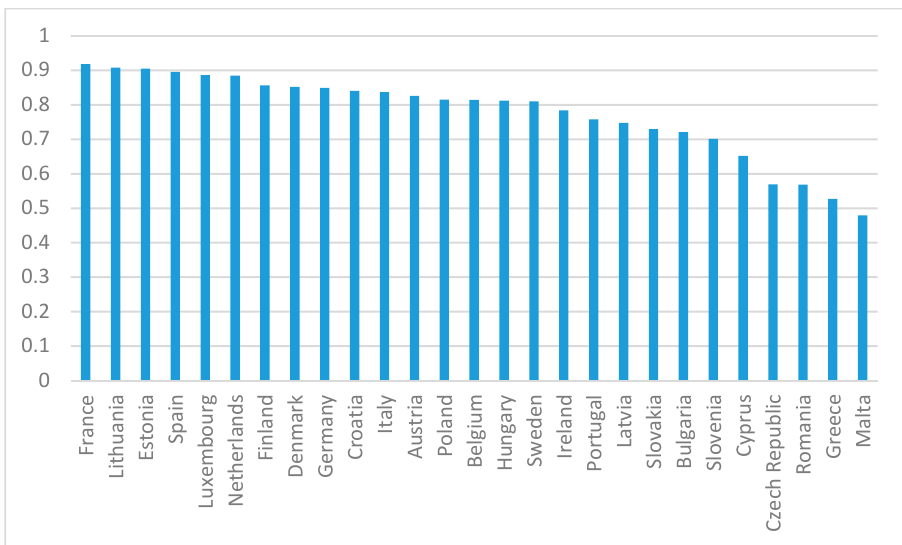
Figure 4. Global Security Index in European Union countries, 2018. Source: Achim et al. (2021b) based on data from Global Security Index 2018 (www.itu.int, accessed on 1 March 2021).